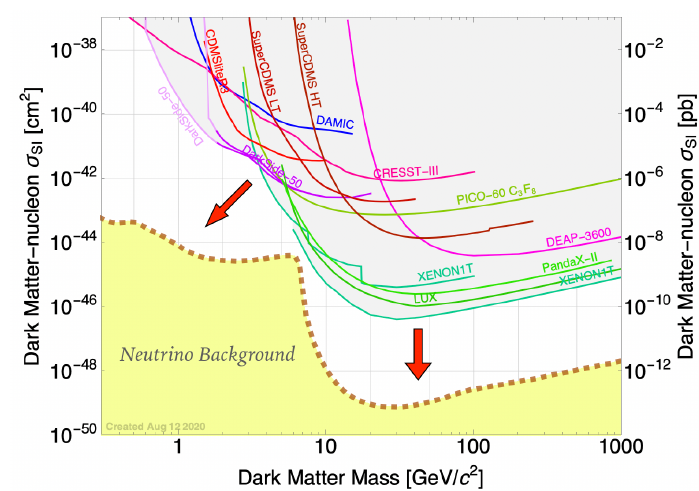
Figure 26: Experimental exclusion regions in spin-independent cross-section vs. mass space. The neutrino "fog" background expectation is shown in yellow at the bottom of the plot. The red arrows indicate directions that forthcoming experiments will push into the parameter space, toward better sensitivity at low mass and in- creased sensitivity at high mass. Image generated using [ 38 ]